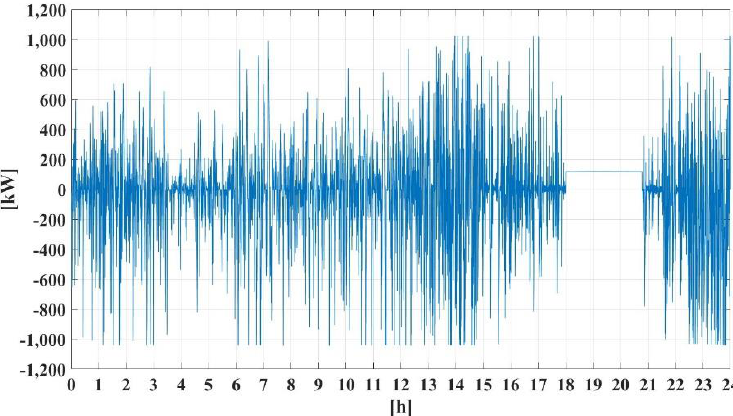
Figure 18. Field test result 3: output power of ESS.